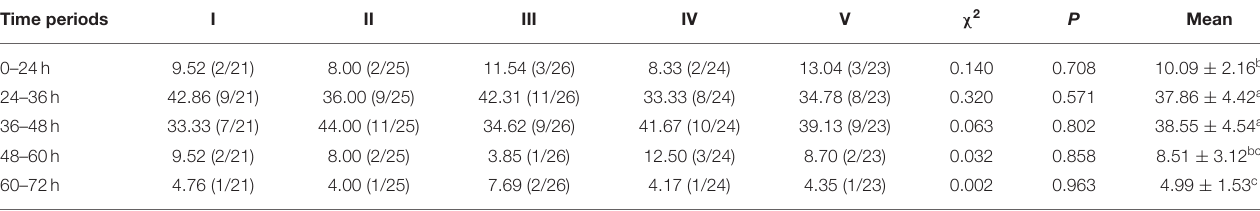
TABLE 1 | Percentage of estrous ewes in different time periods (%).